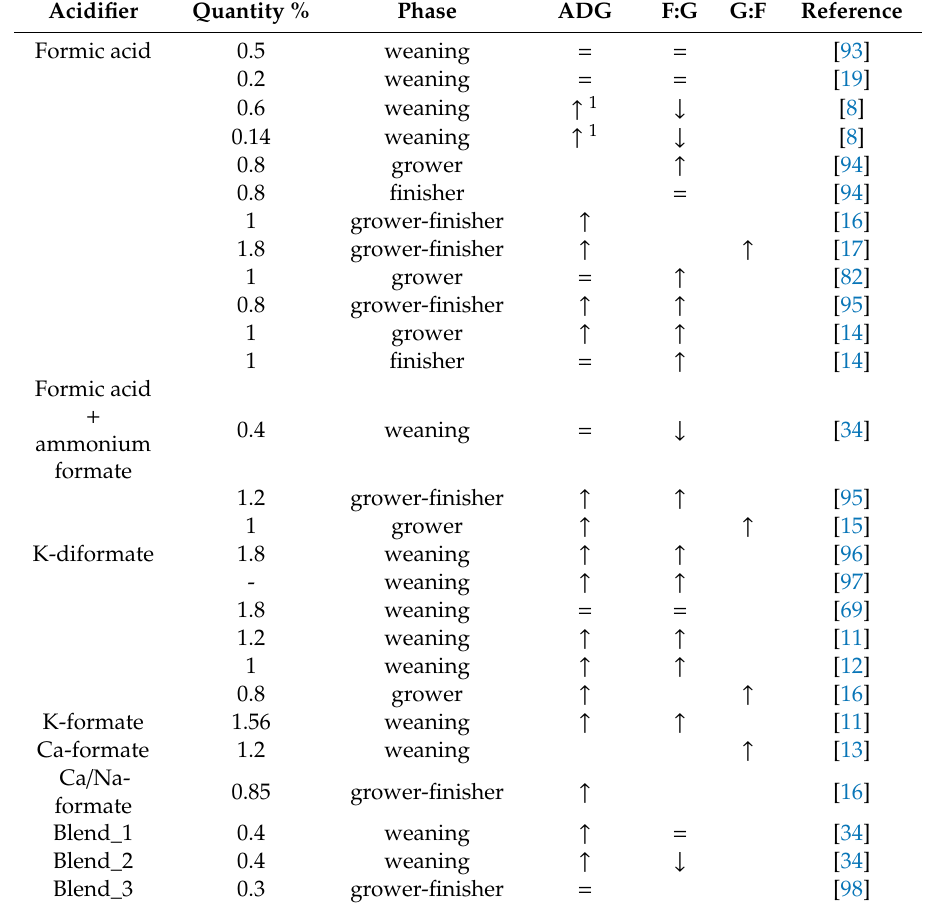
Table 3. Summary of the e ff ects of formic acid and its salts on pig growth performance at di ff erent phase.